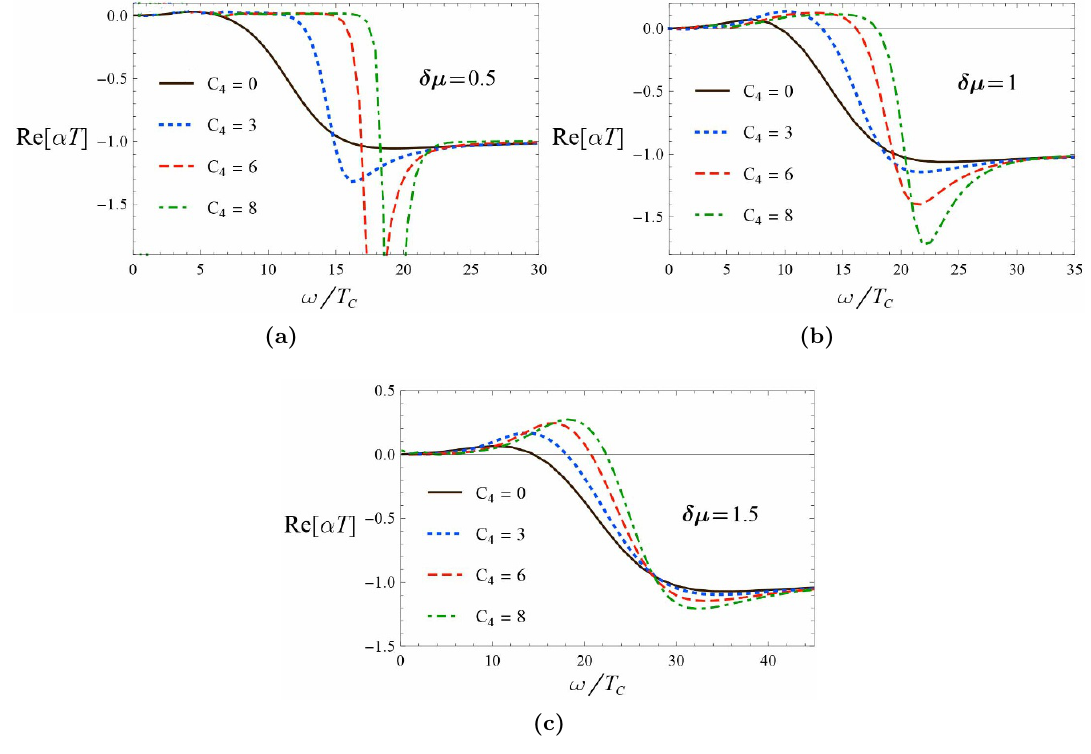
Figure 14. The real part of the thermo-electric conductivity in terms of !=T c for function F ( ) = 2 + C 4 with C 4 4 = 0 ; 3 ; 6 ; 8 (solid curve, dotted curve, dashed curve, and dot-dashed curve) and (cid:14)(cid:22) = 0 : 5 ; 1 ; 1 : 5 ((cid:12)gures (a), (b), and